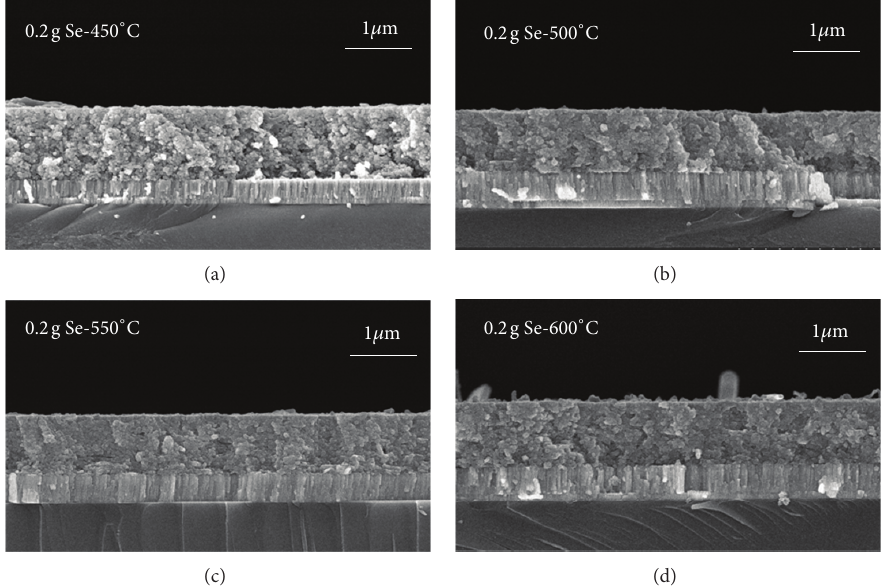
Figure 3: Cross-section observations of the CIS absorber layers as a function of selenization temperature the extra Se content was 0.2 g.